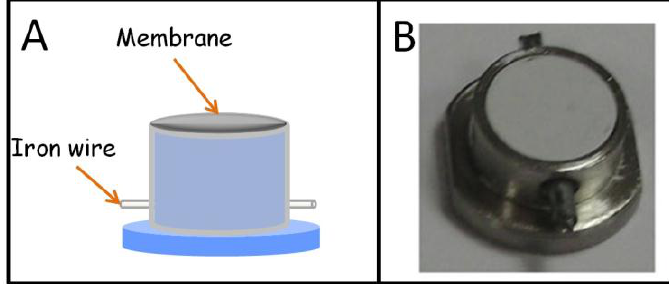
Figure 4. Stir membrane extraction device. ( A ) Diagram of the unit built in plastic; ( B ) picture of the unit built in stainless steel (reproduced with permission from [30], copyright Springer, 2010).